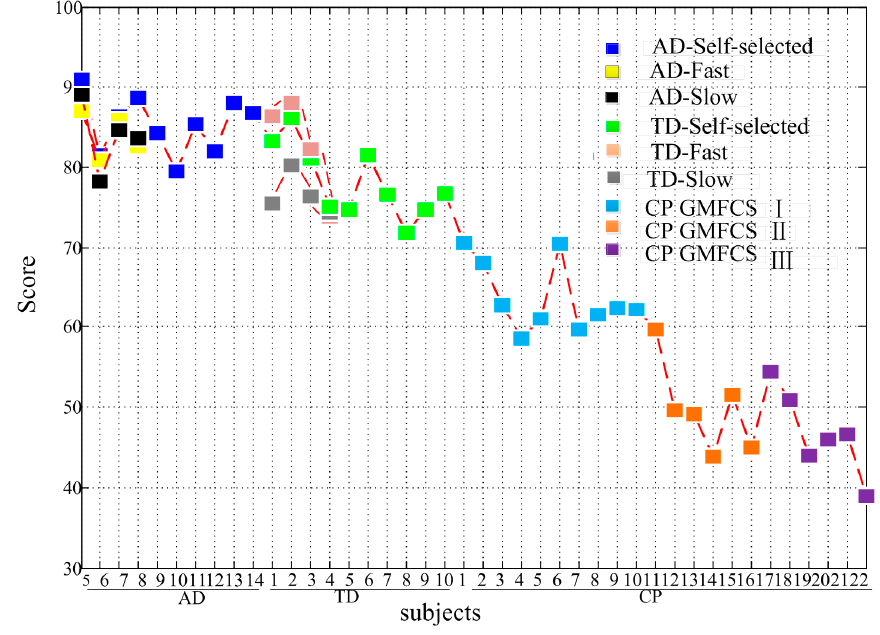
Figure 8. The gait assessment scores of all subjects. Table 4. Speed information of eight healthy